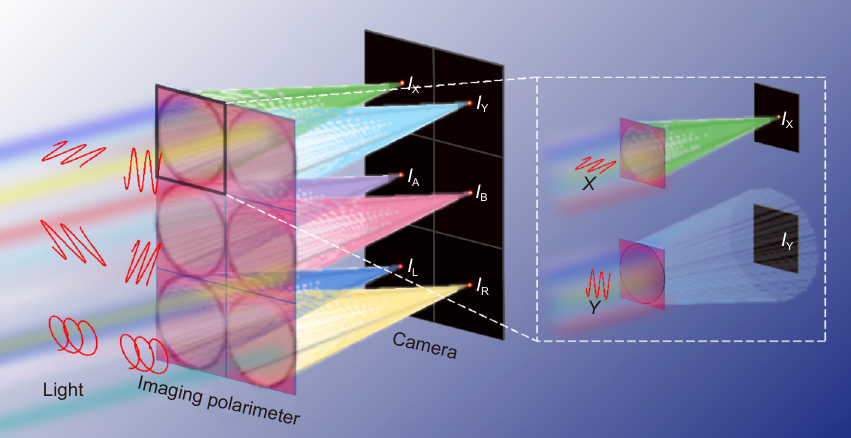
Fig. 1 | The schematic of the continuous broadband achromatic imaging polarimeter. The device is composed of 2×3 sub-arrays, each of which can be regarded as an achromatic focusing lens under a specific polarization basis. The focal spots remain at the same plane under differ- ent incident lights in 9-12 μm. The schematic in the white frame on the right shows the principle of polarization-dependent phase